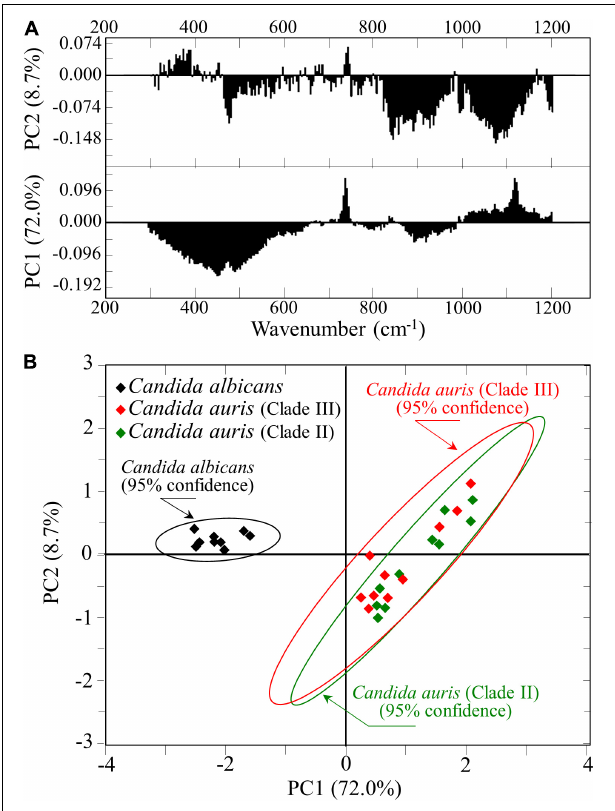
FIGURE 8 | (A) First and second principal components (PC1 and PC2, respectively) of a PCA analysis of Raman spectra at the 10 selected locations from maps of C. albicans and two C. auris clades ( Figures 5 – 7 ); (B) plot of the loading vectors PC1 and PC2 for the spectral region 300–1200 cm − 1